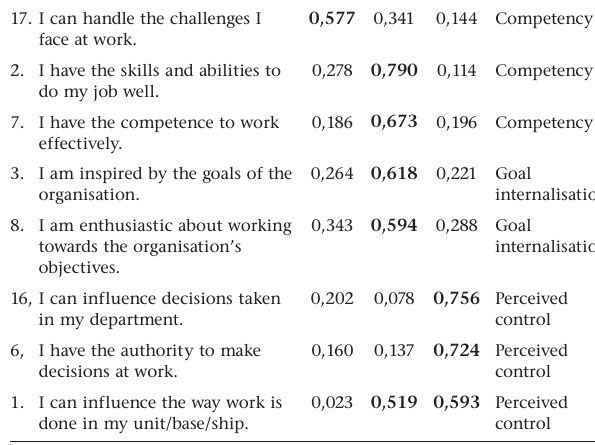
Extraction Method: Principal Component analysis. Rotation Method: Varimax with Kaiser normalization. rotation converged in 7 iterations.